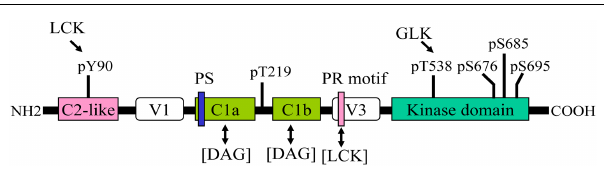
FIGURE 1 | Structural domains and phosphorylation sites of PKC- θ . One-way arrow indicates the phosphorylation of the indicated site by a kinase.Two-way arrow indicates an interaction. PS, pseudosubstrate sequence; PR, proline-rich motif.